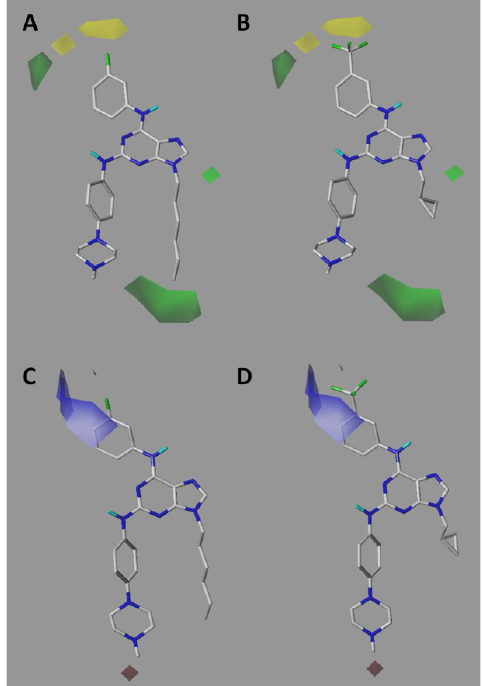
Figure 6. Steric ( A , B ) and electrostatic ( C , D ) contour maps in BTK. The most active compound 5h ( A , C ) is compared against the least active 4d ( B , D ). For the FLT3-ITD (Figure 7), the steric contour map shows two green polyhedra around the isopentyl group in N-9 of 5a ; the most active are on FLT3-ITD (IC 50 = 0.23 mM). At the end of the octyl chain of compound 5j , the least active of the series (IC 50 = 20.28 mM) shows a yellow polyhedron. Therefore, we postulate that FLT3-ITD has greater free- dom than Bcr-Abl but less than in BTK; this helps explore the bulky substitutions in N-9. These results are corroborated by the fact that active compounds 5b (IC 50 = 0.38 mM), 5d (IC 50 = 0.46 mM) and 5e (IC 50 = 0.50 mM) have chains that do not exceed the region delimited by the green polyhedra. There are also two green polyhedra in the ortho - and para -positions of the phenylamino fragment on C-6, which indicates that the presence of bulky substituents there might increase the inhibitory activity. The electrostatic contour map for FLT3-ITD (Figure 7A,B) indicates similar behaviour to Abl and BTK. There is a large blue polyhedron on the meta- and para- positions of the phenylamino fragment on C- 6.